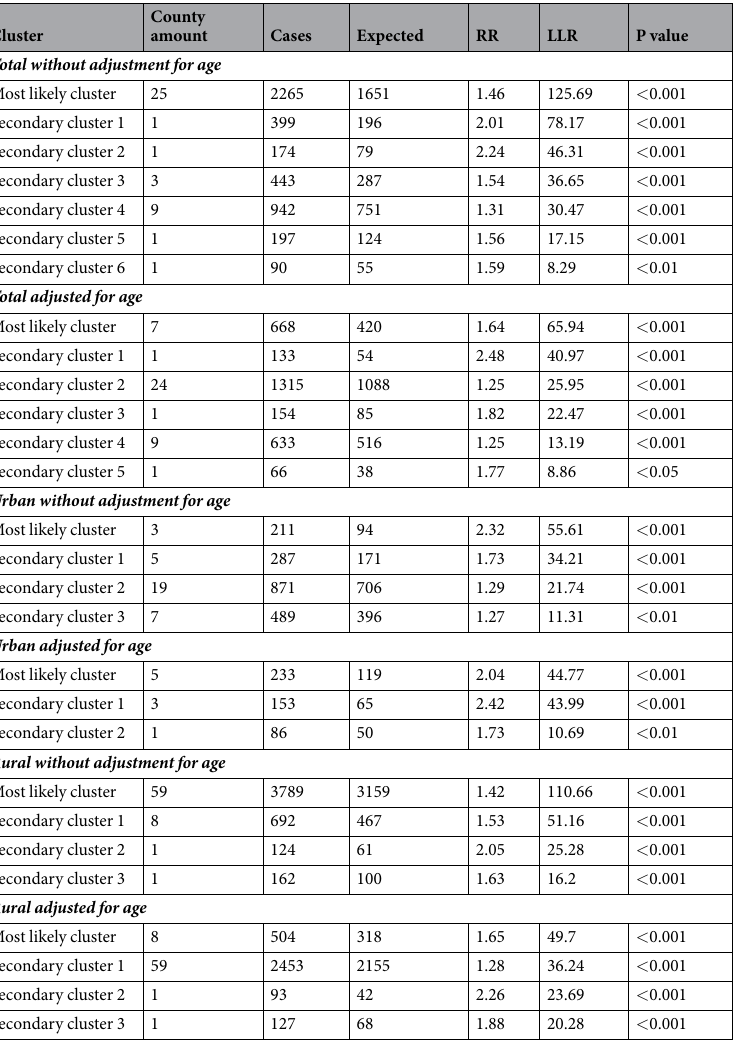
Table 1. Results of the spatial scan analysis of female breast cancer mortality at the county level in Shandong for the years 2011 to 2013. Note: “Most likely cluster” was defined when the maximum log likelihood ratio (LLR) with statistical significance was detected by Monte Carlo simulation in the spatial analysis; the other LLR values with statistical significance were identified as the “Secondary cluster”. The relative risk (RR) was the ratio of the mortality inside a cluster area to the mortality outside a cluster